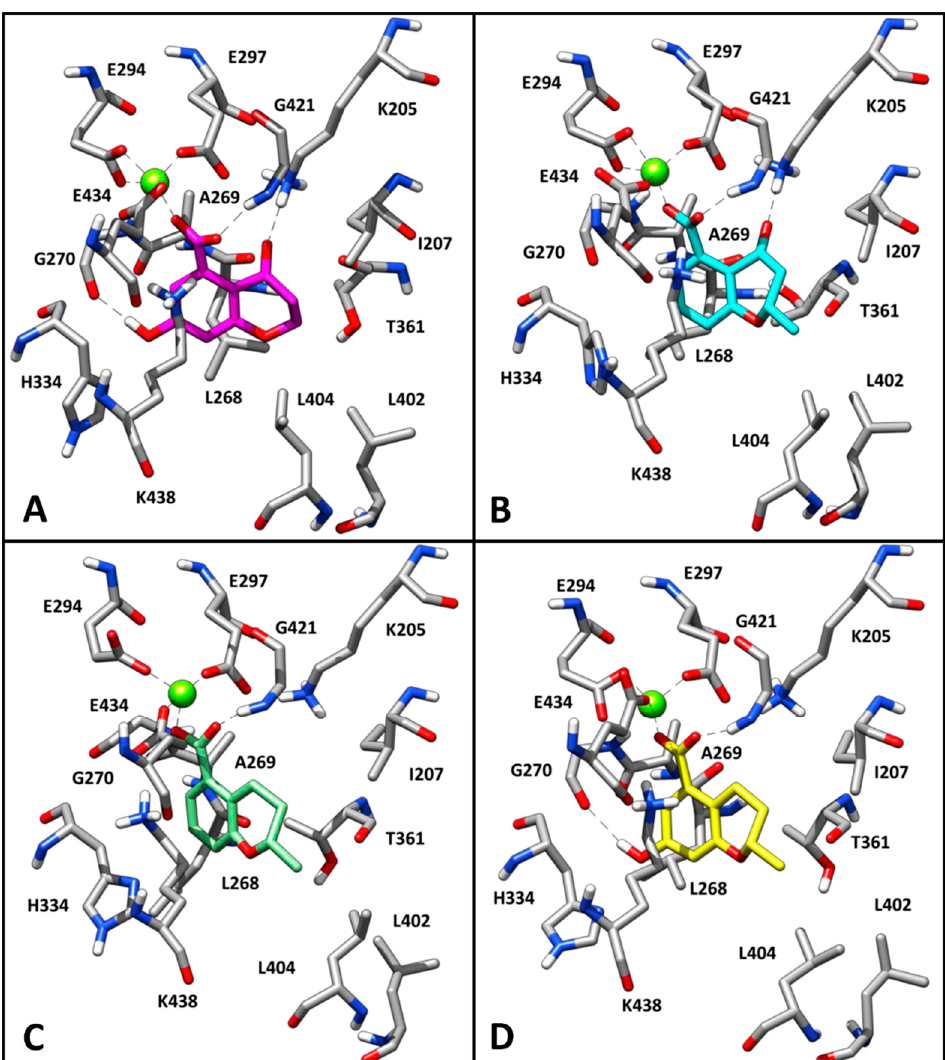
Figure 3. Minimized average structure of compounds 2 ( A ), 3 ( B ), 4 ( C ) and 5 ( D ) docked into MbtI binding site.